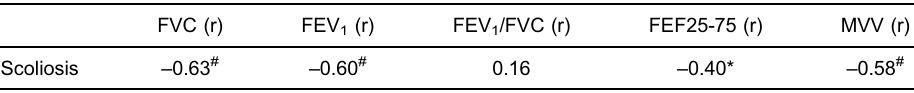
Table 3. Correlation between scoliosis and spirometric variables measured in participants with myelomeningocele. FVC (r) FEV 1 (r) FEV 1 /FVC (r) FEF25-75 (r) MVV (r) Scoliosis – 0.63 # – 0.60 # 0.16 – 0.40* – 0.58 # FVC: forced vital capacity; FEV 1 : forced expiratory volume at the fi rst second; FEF25 – 75%: forced expiratory fl ow 25 – 75 between 25 and 75% of FVC; MVV: maximal voluntary ventilation; r: correlation analysis by Spearman coef fi cient (*P p 0.05 and # P p 0.01).